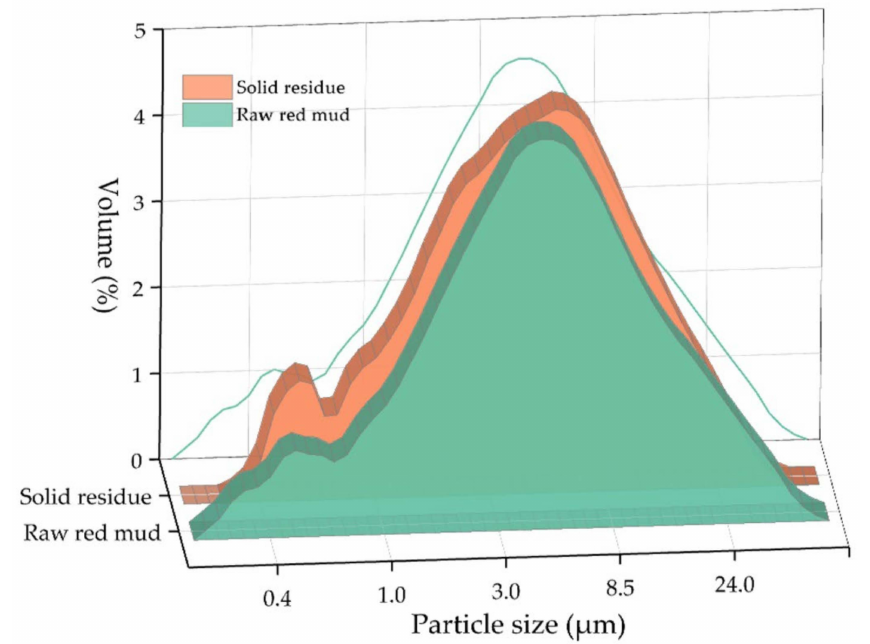
Figure 3. Particle size distribution (PSD) of the RM-ESPD and solid residue after MgSO 4 leaching (green line is the projection of the raw red mud PSD on the ZY